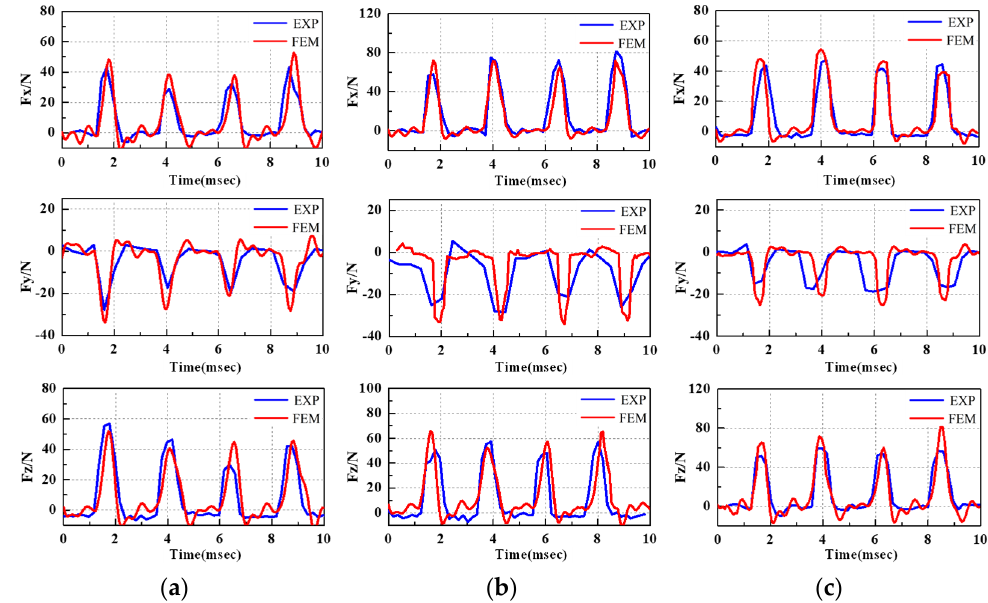
Figure 5. Experimental and simulated cutting forces: ( a ) θ = 35°, V c = 100 m/min, f z = 0.05 mm/rev; ( b ) θ = 55°, V c = 100 m/min, f z = 0.09 mm/rev; ( c ) θ = 75°, V c = 100 m/min, f z = 0.03 mm/rev.